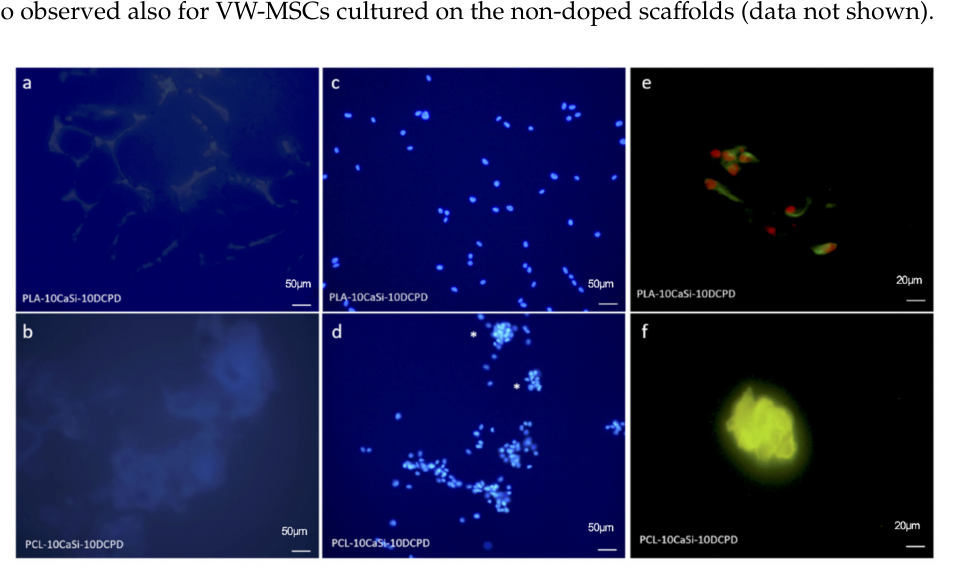
Figure 6. DAPI staining for PLA-10CaSi-10DCPD ( a ) and PCL-10CaSi-10DCPD ( b ) without cells and in the presence of 72 h cultured cells: PLA-10CaSi-10DCPD ( c ), PCL-10CaSi-10DCPD ( d ). Immunofluorescence analysis for alpha-tubulin of 72 h cultured cells on PLA-10CaSi-10DCPD ( e ) and PCL-10CaSi-10DCPD ( f ). Scale bar = 50 µ m for a–d and 20 µ m for e,f, *indicate spherical